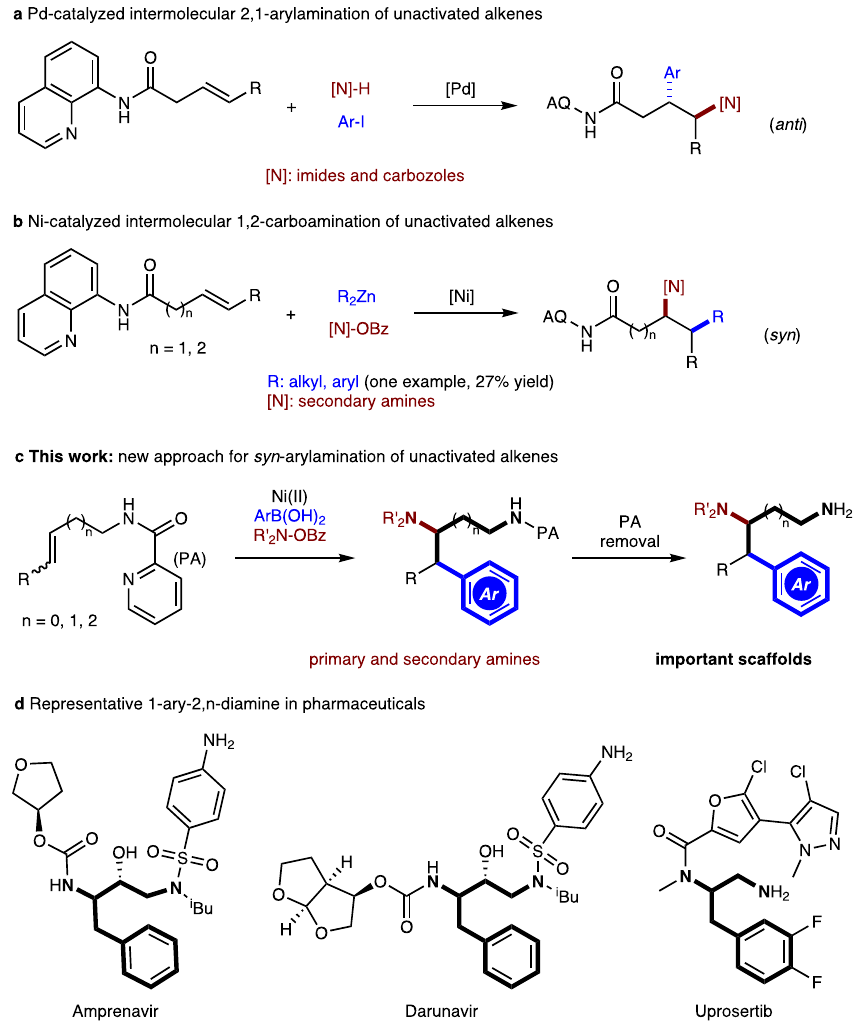
Fig. 1 Background and synopsis of current work. a Pd-catalyzed intermolecular 2,1-arylamination of unactivated alkenes. b Ni-catalyzed intermolecular 1,2-carboamination of unactivated alkenes. c This work: an approach for syn -arylamination of unactivated alkenes. d Representative 1-ary-2,n-diamine in